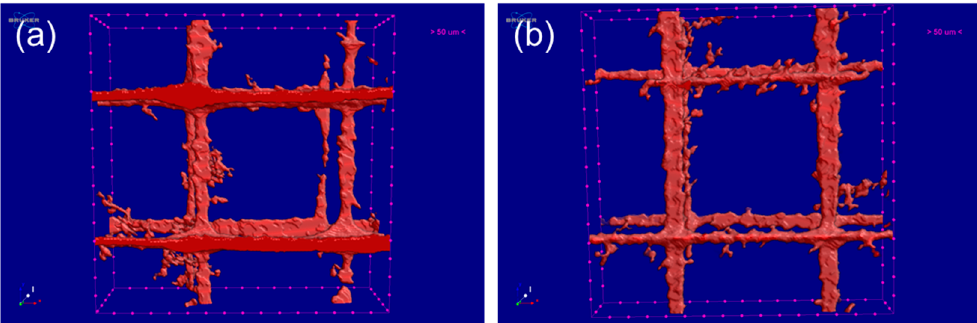
Figure 7. XCT scanning of pore size of 3D printed ( a ) PLA and ( b ) 10 wt% PLA/ CLRS-1 composites.